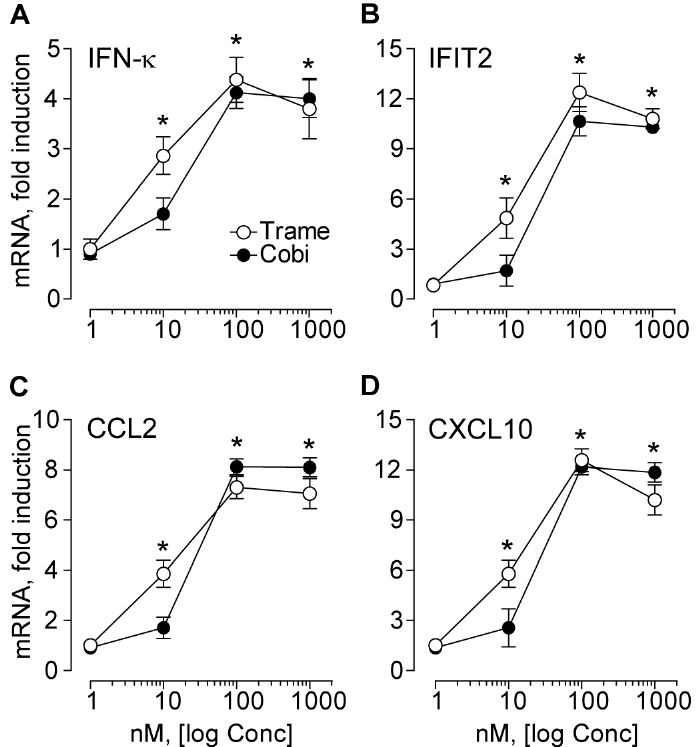
Figure 2. Trametinib and cobimetinib induce de novo gene expression dose-dependently. ( A – D ) quantitative real-time RT-PCR analysis was performed in total RNA extracted from normal human keratinocytes treated for 6 h with the two distinct drugs, at the concentrations indicated in the figure. Data are expressed as mean ± S.D. ( n = 4 per condition). * p < 0.05 versus untreated controls.